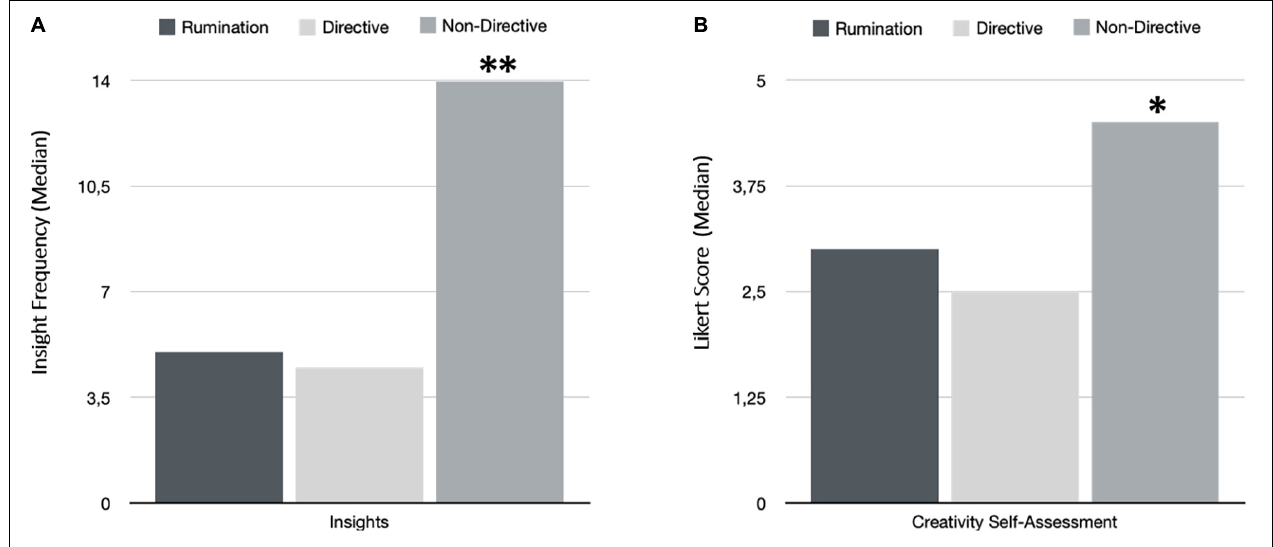
FIGURE 2 | Graphics showing the numbers of insights registered (A) and the levels of creativity perceived by the subjects (B) during each experimental condition evaluated after coaching session. Significant differences can be observed between the greater number of insights and the perception of higher levels of creativity in non-directive coaching condition compared to the other conditions (rumination and non-directive coaching). Insights: ** p < 0.01; Self-assessment: ∗ p < 0.05.